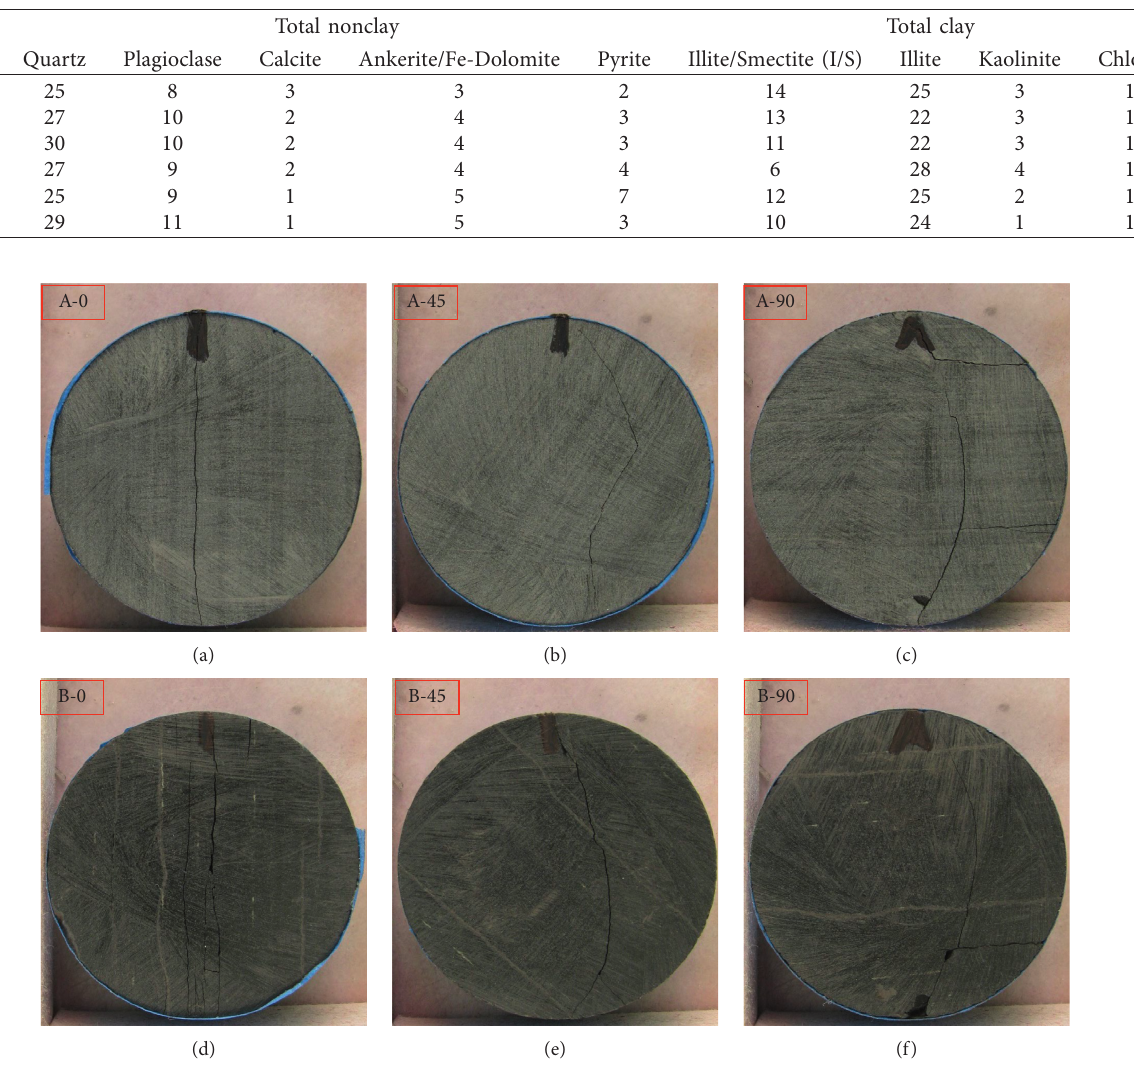
Figure 7: Stress-displacement curves of observation points of homogeneous model. (a) Center points of test and simulation test pieces. (b) 5 observation points of simulation test pieces. Table 3: Clay mineral analysis of test specimens.